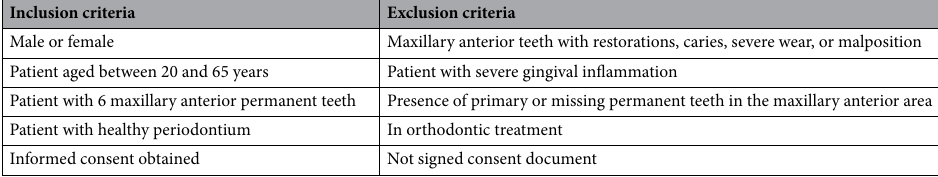
Table 2. Inclusion and exclusion criteria used to select participants for this study.